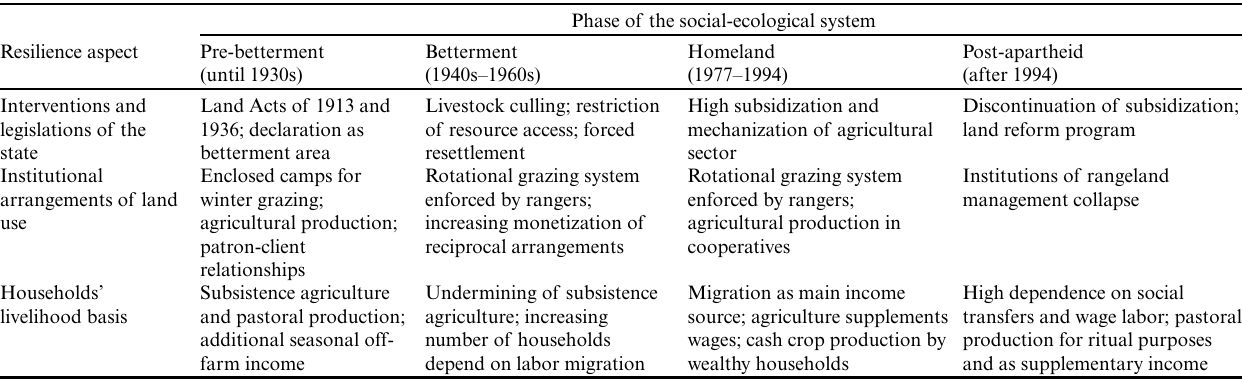
Table 1. Historical perspective on the resilience of the social subsystem, indicating state interventions, institutional changes, and resulting socioeconomic dynamics during the 20th